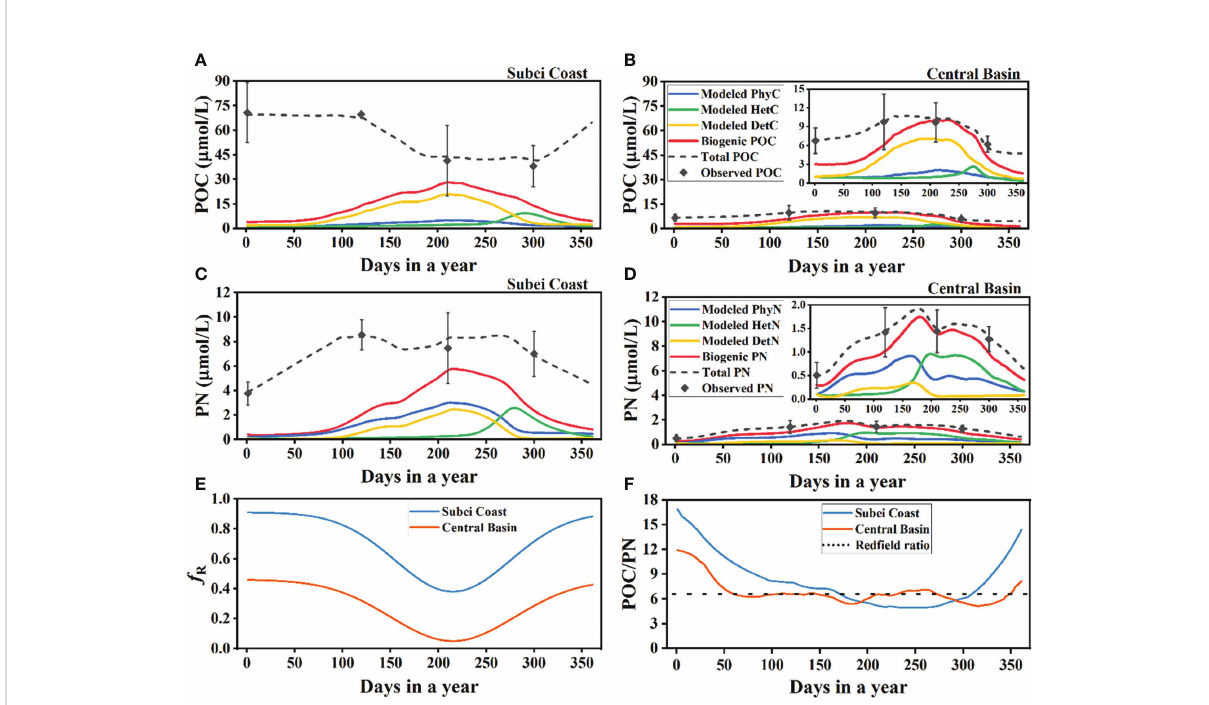
FIGURE 9 Results of the ecosystem model. (A, B) Modeling results of particulate organic carbon (POC) in the Subei coast region and central basin. (C, D) Modeling results of particulate nitrogen (PN) in the Subei coast region and central basin. The inset view in panels (B) or (D) shows a related enlarged version. (E) Modeling results of f R after optimization in the Subei coast region and central basin. (F) Modeling results of the POC/PN ratio in the Subei coast region and central basin. Phy C and Phy N , phytoplankton carbon and nitrogen; Het C and Het N , heterotrophs carbon and nitrogen; Det C and Det N , detritus carbon and nitrogen; Biogenic POC (PN) = modeled Phy C + modeled Het C + modeled Det C (modeled Phy N + modeled Het N + modeled Det N ); Total POC or PN, the sum of biogenic and resuspended POC or PN; Observed POC and PN, observed value of POC and PN in situ (means ± SD of all stations in a given region after depth-weighted averaging for each station); f R , the ratio of resuspended particles to total suspended